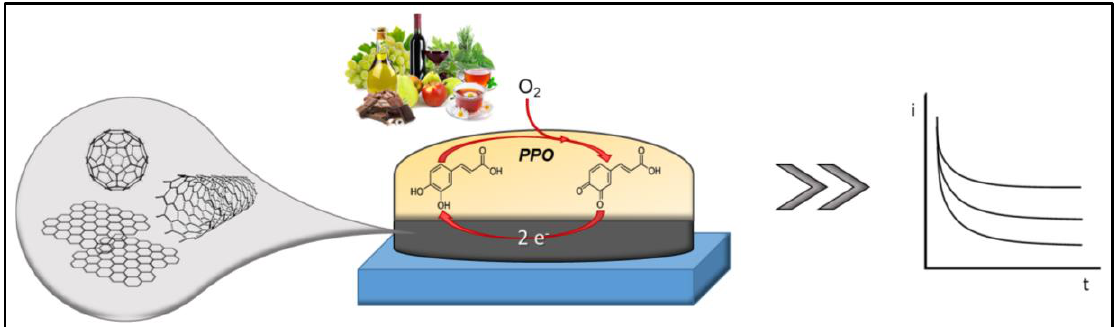
Figure 3. Schematic representation of polyphenols (caffeic acid) detection onto a nanomaterial based enzyme (polyphenols oxidase) sensor.